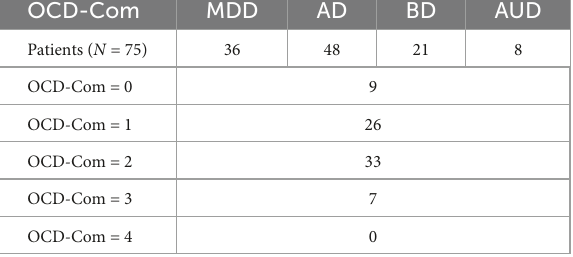
TABLE 4 Number of comorbidities in patients with obsessive-compulsive disorder (OCD). OCD-Com MDD AD BD AUD Patients ( N =